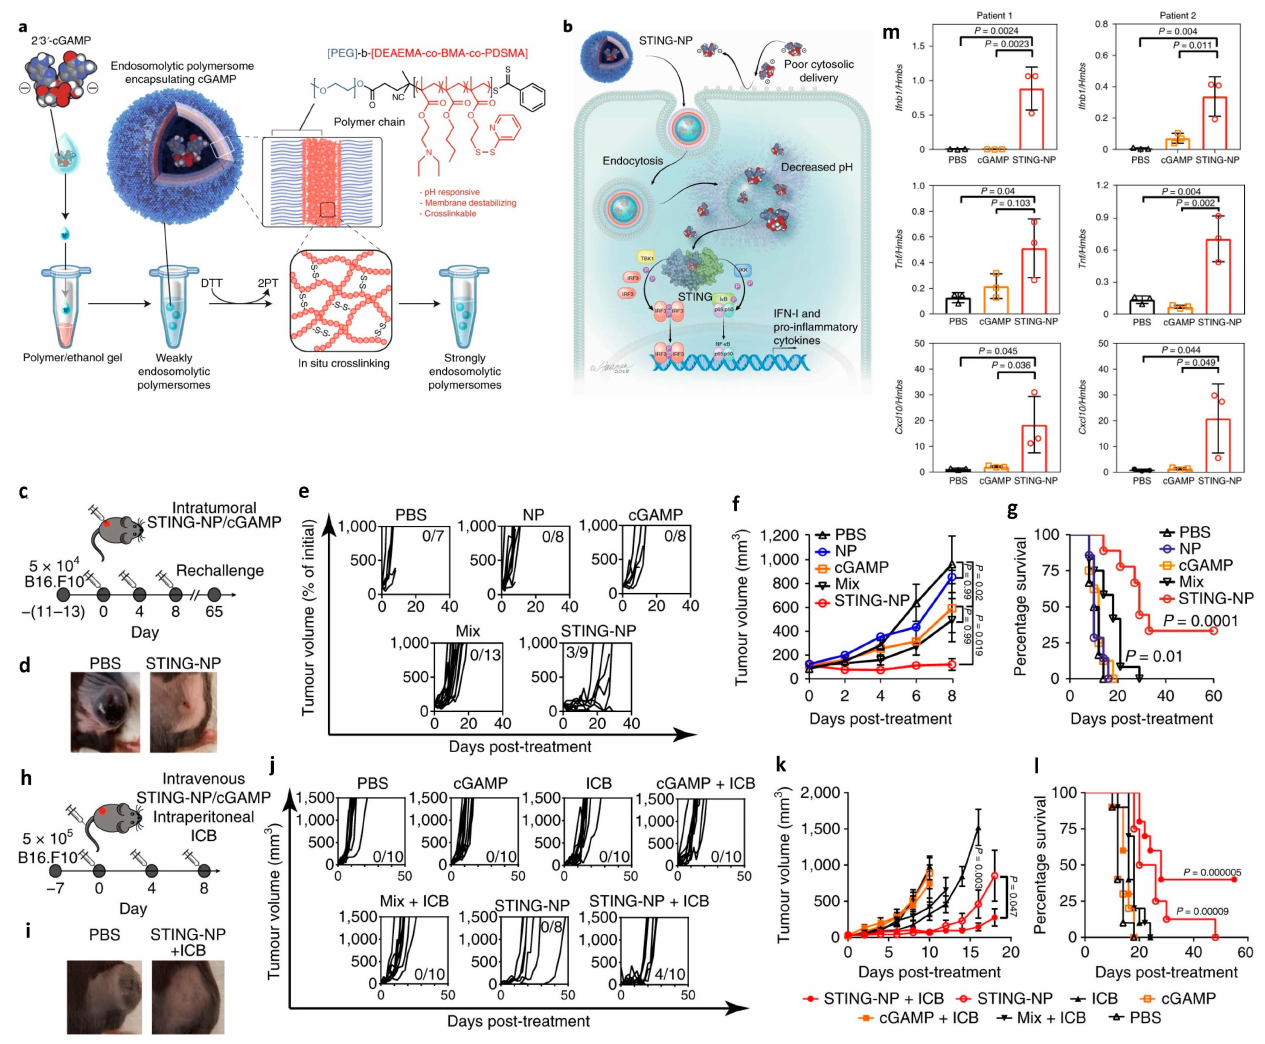
Figure 9. ( a ) Schematic of the STING-NP structure and strategy for enhancing intracellular de- livery of 2 (cid:48) 3 (cid:48) -cGAMP. cGAMP is encapsulated in endosomolytic polymersomes assembled from pH-responsive diblock copolymers. After polymersome self-assembly and cGAMP loading, polymer chains are crosslinked in situ via partial reduction of pyridyl disulfide groups with DTT, resulting in the formation of disulfide crosslinks. 2PT, 2-pyridinethione. ( b ) STING-NPs enhance intracellular uptake of cGAMP and, in response to decreased pH within endosomal compartments, disassemble and promote endosomal escape of cGAMP to the cytosol. IKK, I κ B kinase; I κ B, inhibitor of κ B; IRF3, IFN regulatory factor 3; TBK1, TANK-binding kinase 1. ( c ) Intratumoral administration and tumor rechallenge scheme for mice with a single established B16.F10 tumor. Mice with 100 mm 3 subcutaneous tumors were administered STING-NPs, free cGAMP, empty nanoparticles (NPs), a physical mixture of empty NPs and cGAMP (mix), or PBS intratumorally three times, 4 d apart. ( d ) Photographs of tumors 8 d after treatment. The experiment was conducted three times indepen- dently with similar results. ( e ) Spider plots of individual tumor growth curves, with the numbers of complete responses denoted. The experiment was conducted three times independently with similar results. ( f ) Mean tumor volume from three independent experiments (for PBS, NP, cGAMP, mix and STING-NP; n = 7, 8, 8, 13 and 9 biologically independent samples, respectively; Kruskal–Wallis test with Dunn’s multiple comparisons test). ( g ) Kaplan–Meier survival curves of mice treated with the indicated formulation using a 1500 mm 3 tumor volume as the endpoint criteria (for PBS, NP, cGAMP, mix and STING-NP, n = 7, 8, 8, 13 and 9 biologically independent samples, respectively; two-tailed Mantel–Cox test). ( h ) Treatment scheme for mice treated intravenously with cGAMP